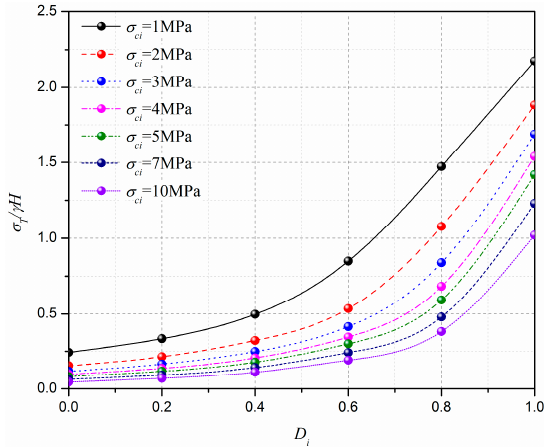
Figure 14. Effect of